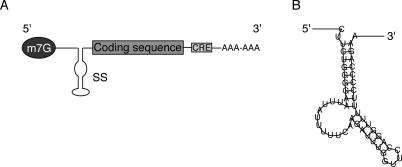
Structure of Yeast mRNA(A) The mRNA has a tripartite structure consisting of a 5′-UTR, a coding region, and a 3′-UTR. CRE, cis-acting regulatory element; m7G, 7-methyl-guanosine cap; SS, secondary structure.(B) The computed minimum free energy secondary structure for the 5′-UTR of the gene YBR296C-A.